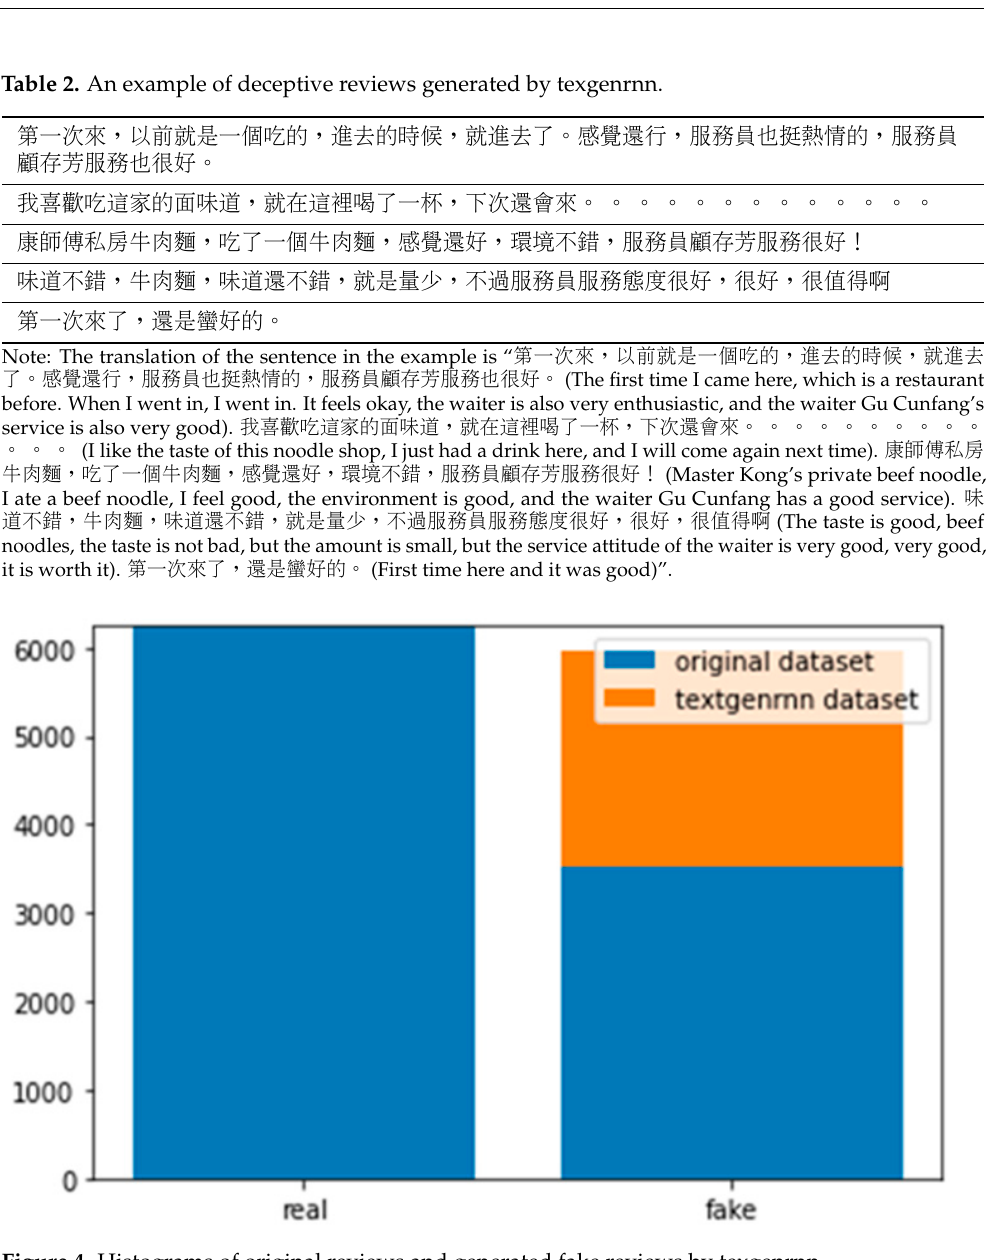
Figure 4. Histograms of original reviews and generated fake reviews by texgenrnn.